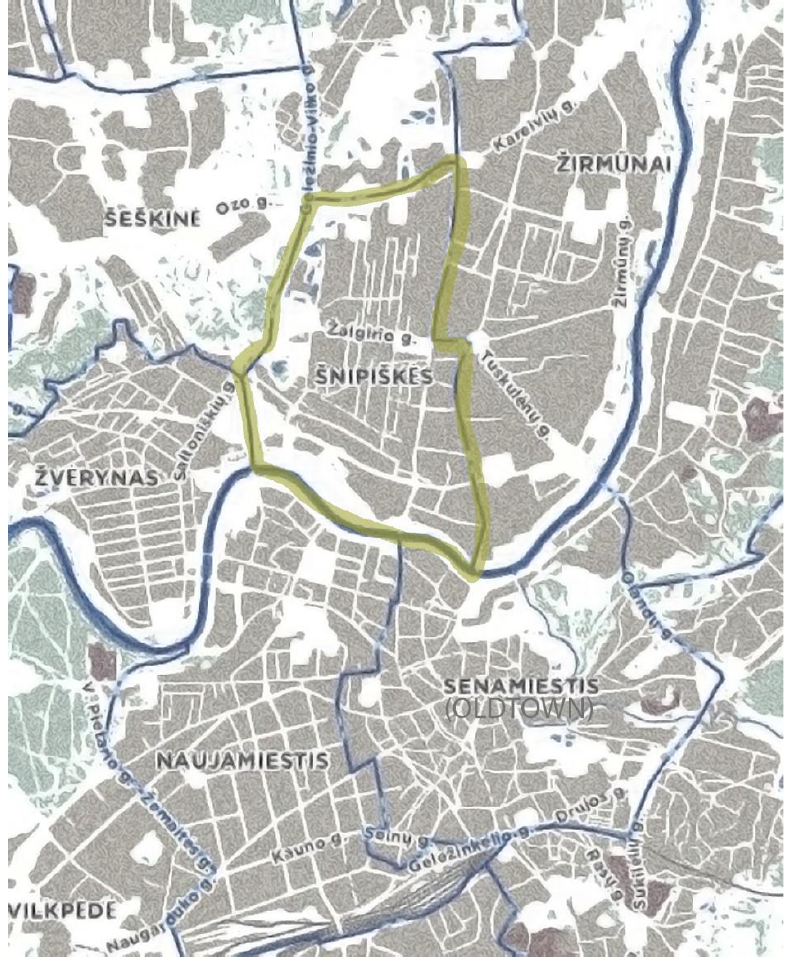
Figure 5. A map of Vilnius with the location of Šnipiškes. Image by A. Gabrėnas.